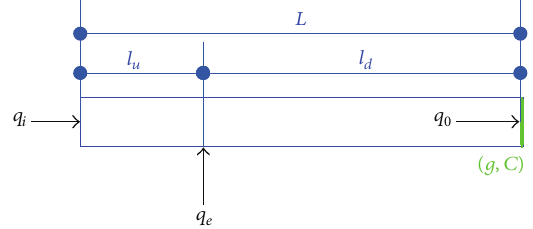
Figure 18: Single road with endogenous traffic